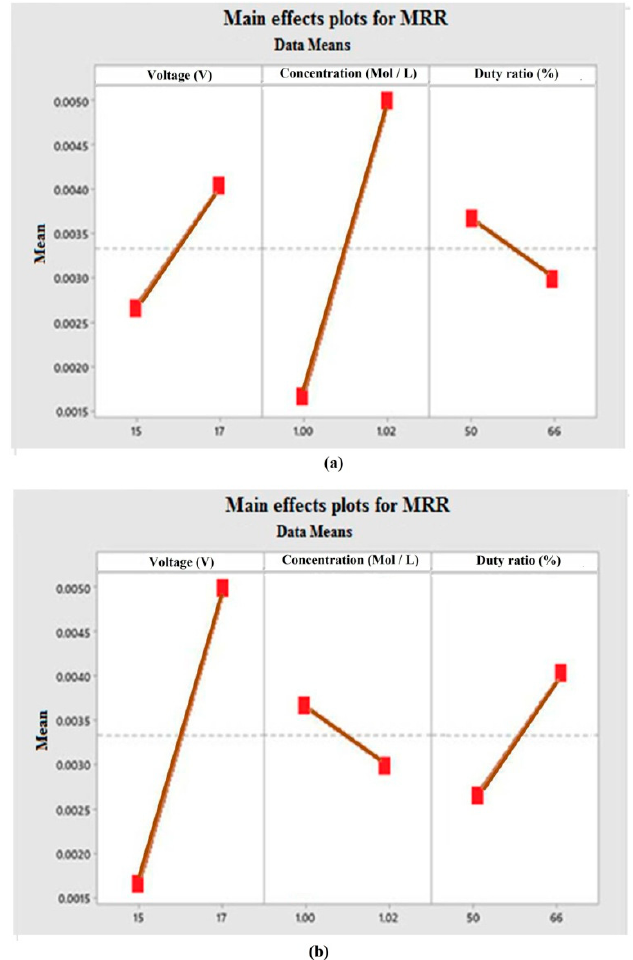
Metals 2021 , 11 , x FOR PEER REVIEW Figure 2. Contribution of process parameter on MRR ( a ) bare tool ( b ) additive tool. Table 3. Comparison between Bare Tool and Additive Tool for MRR .